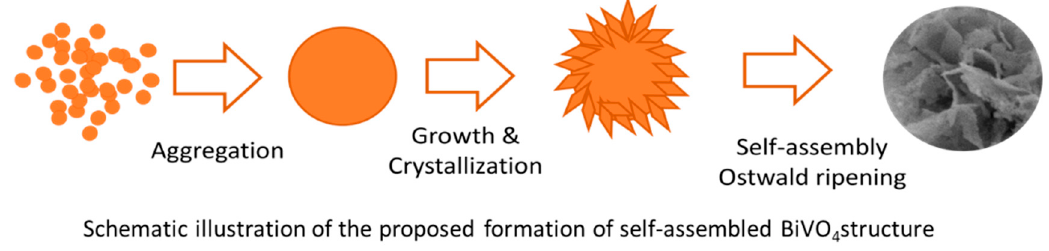
Figure 5. Schematic illustration of the proposed formation of flower-like BiVO 4 microsphere structure.